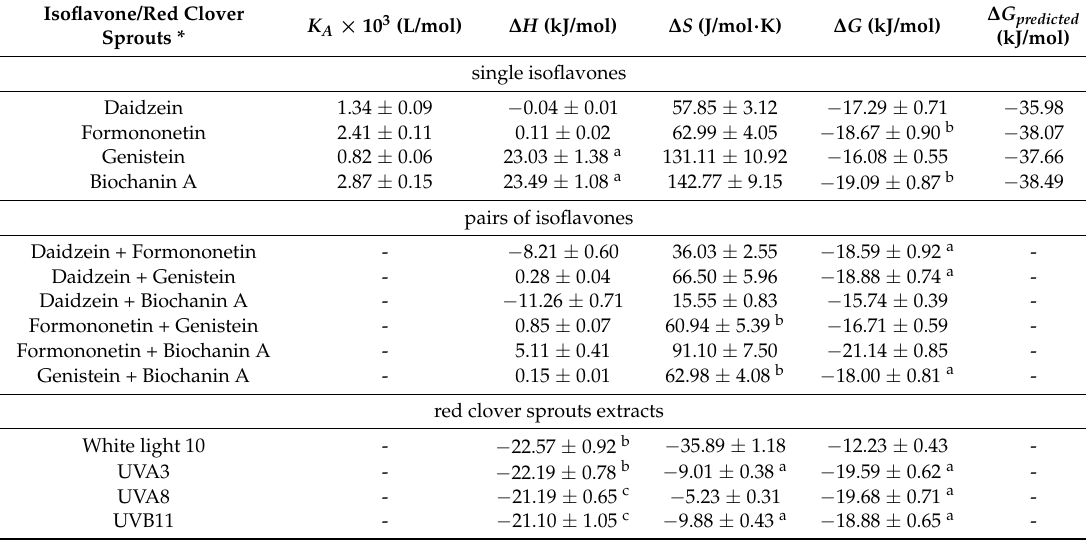
Table 2. Thermodynamic parameters of the interactions of isoflavones with actin determined by ITC and docking simulation ( ∆ G predicted